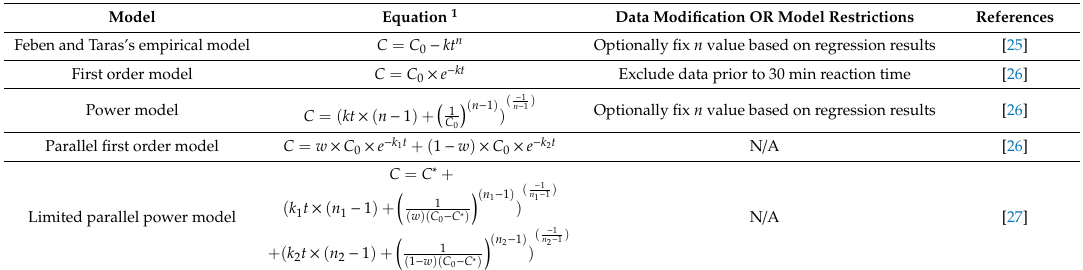
Table 2. Five Models evaluated by Wu (2020) [24] and their empirical